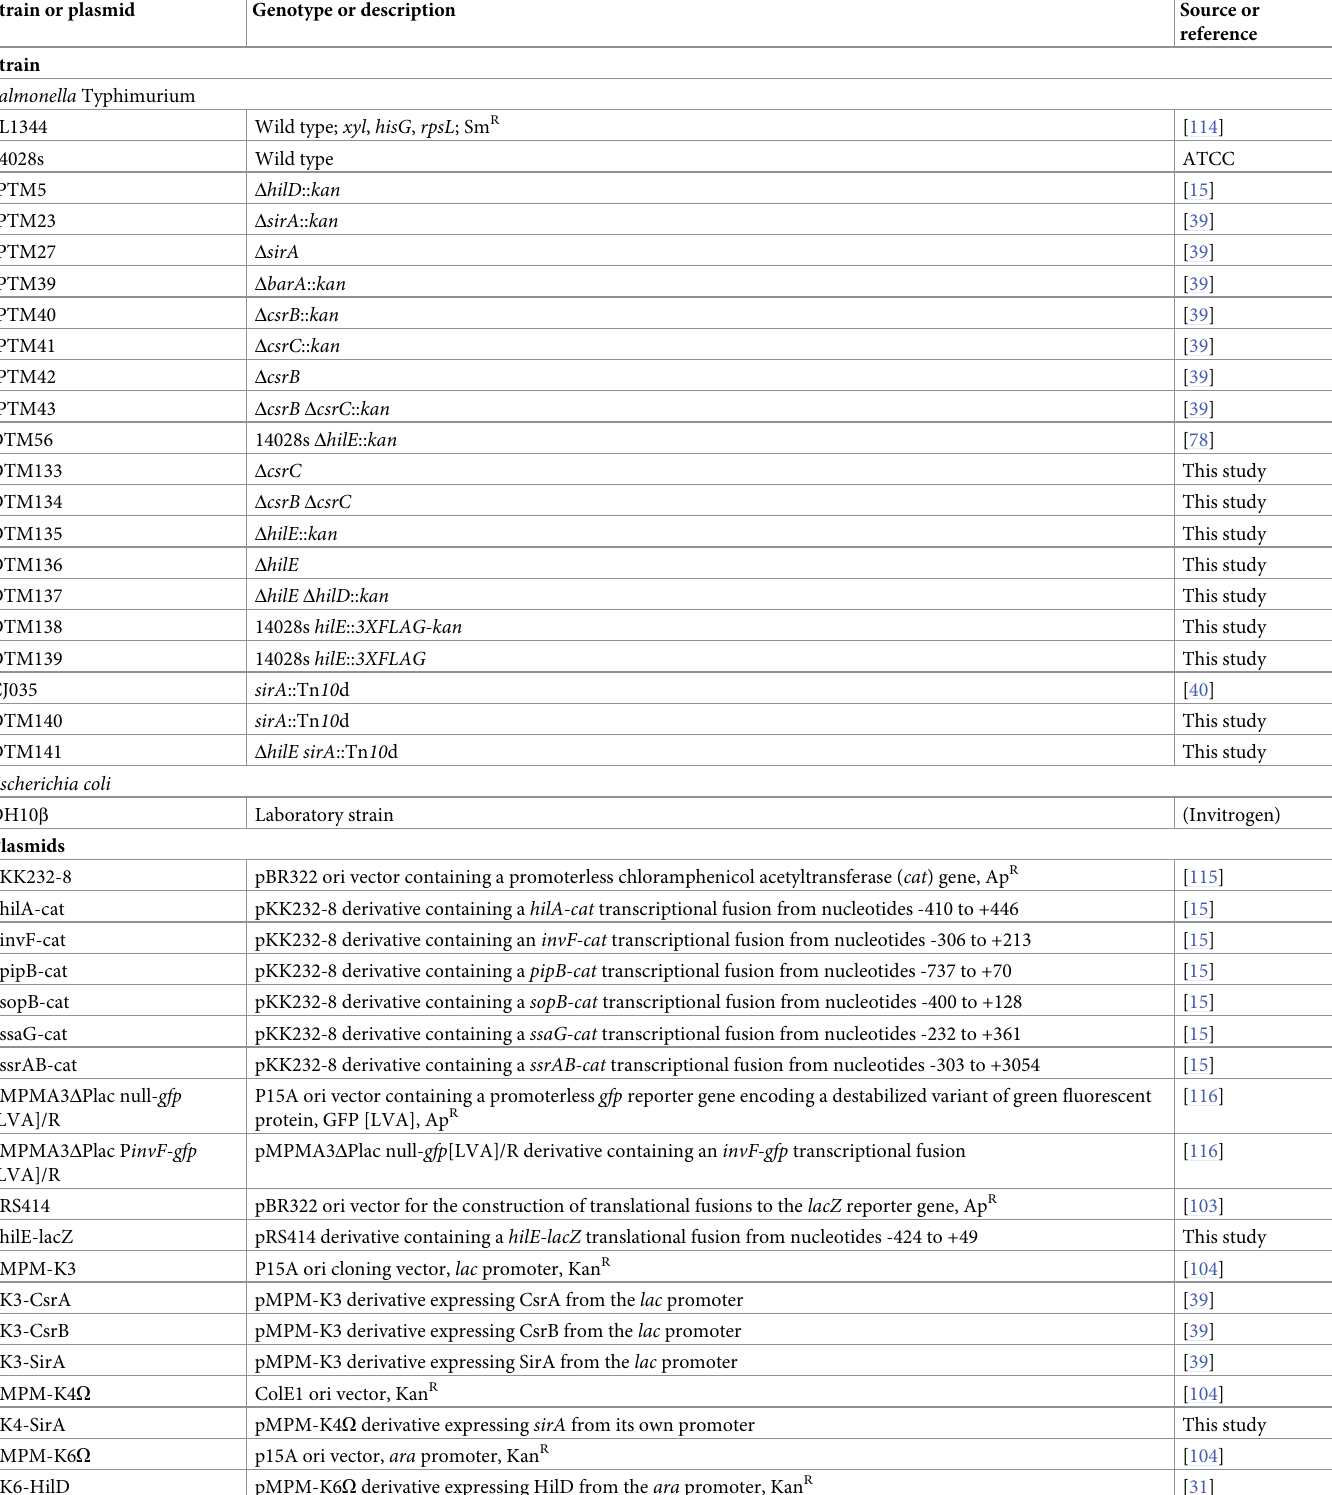
Table 1. Bacterial strains and plasmids used in this study. Strain or